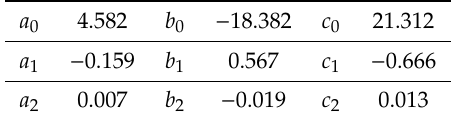
Table 2. Coe ffi cients of vapor pressure